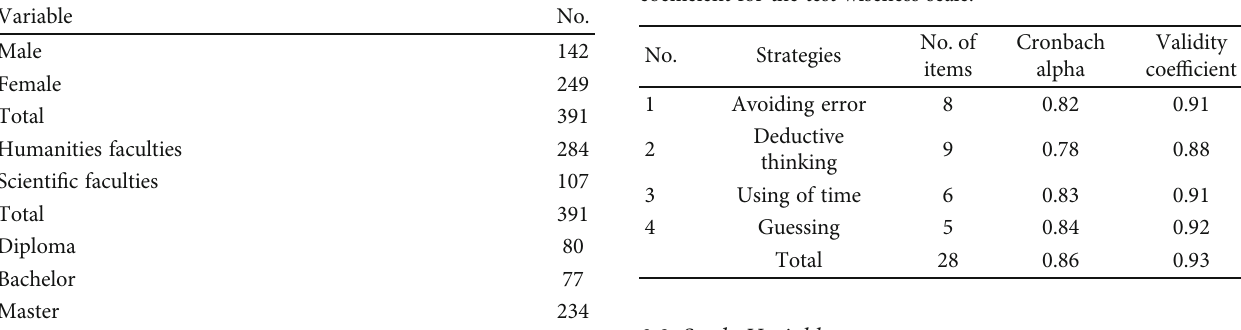
Table 3: Reliability coe ffi cient cronbach alpha and self-validity coe ffi cient for the test wiseness